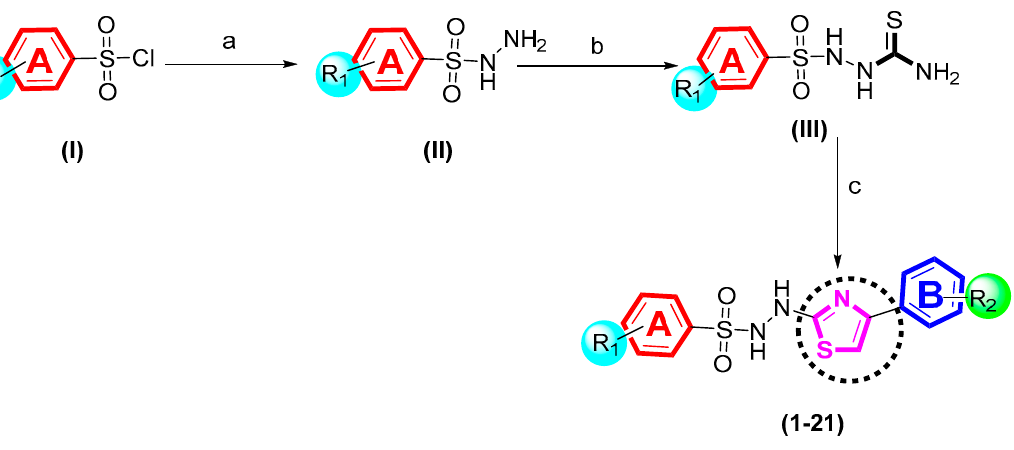
Table 1. Different substituents, acetylcholinesterase and butyrylcholinesterase activities of thiazole- bearing sulfonamide analogs.